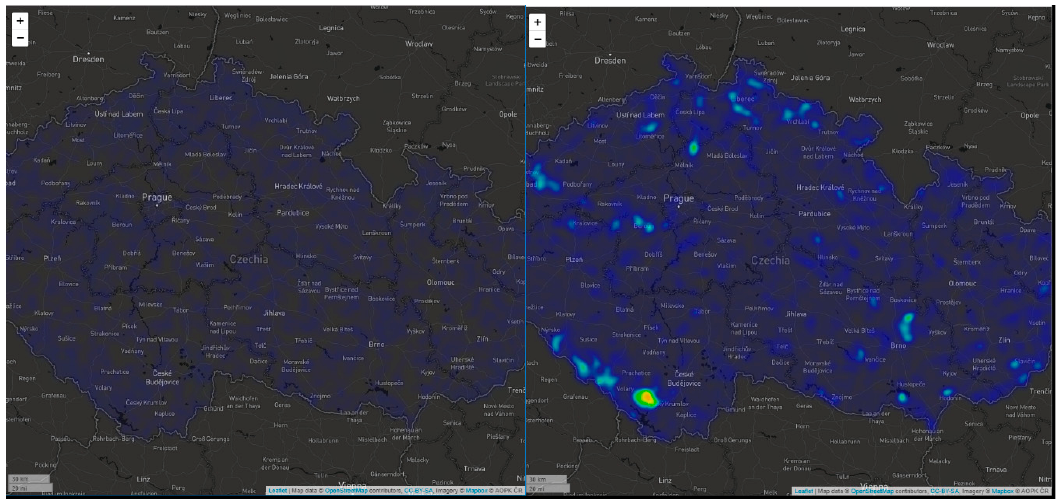
Figure 8. Map output of Leaflet.heat—testing on 10,000 and 50,000 of points.